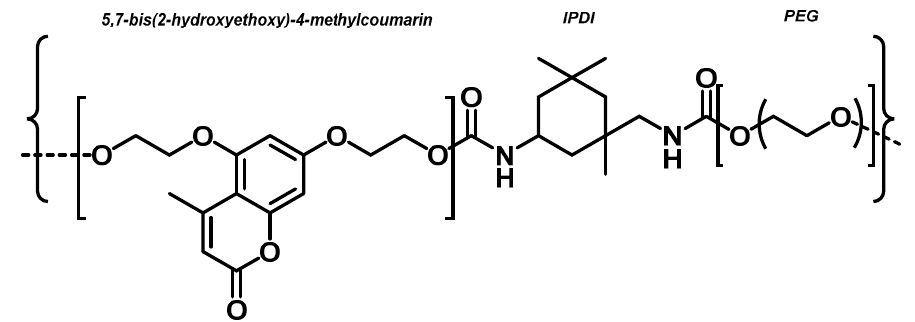
Figure 4. Repairing process of a coumarin-functionalised polyurethane (left) and related tensile–stress curves of the original and repaired polymer (right). Reproduced from [116] with permission from the Royal Society of Chemistry.